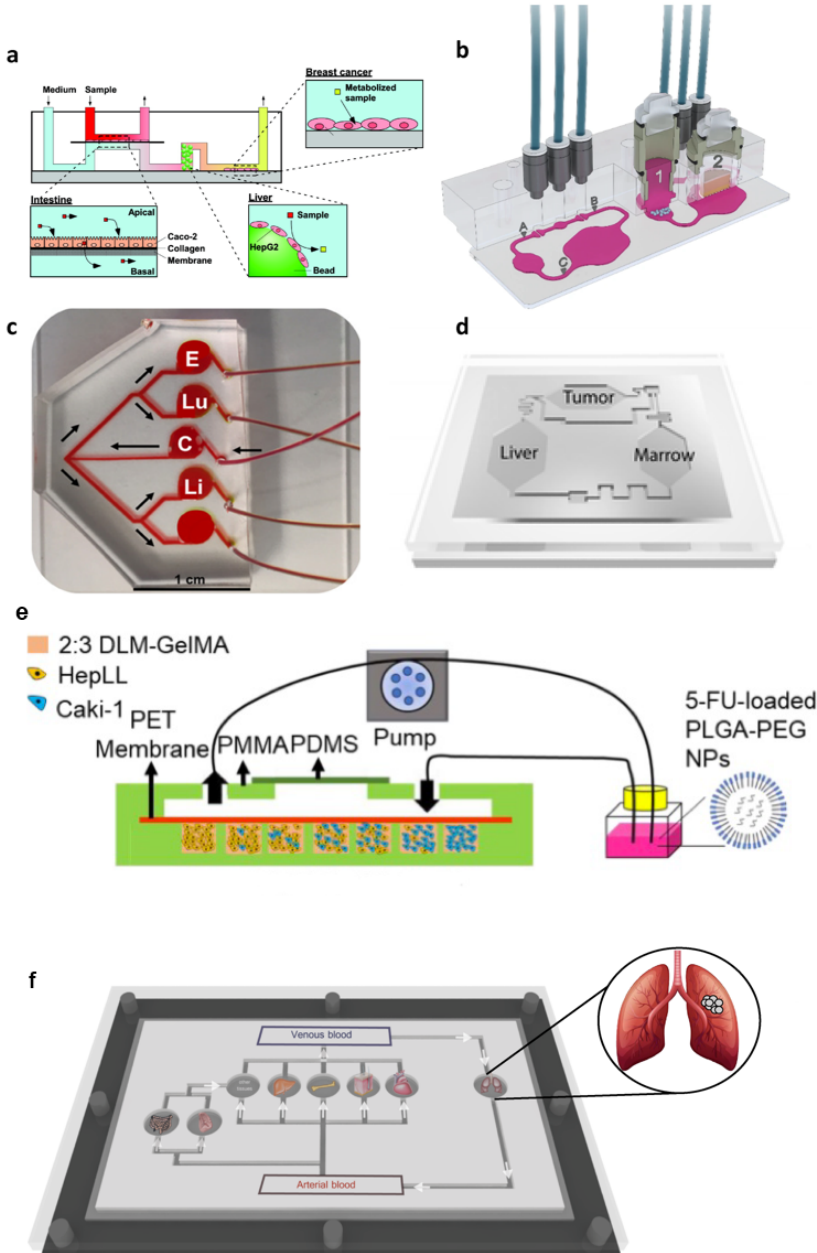
Figure 4. Multiorgan on chip for modeling cancer metastasis. ( a ) An intestine-liver-tumor multior- gan device provided with systemic and intestinal perfusion. Reproduced with permission